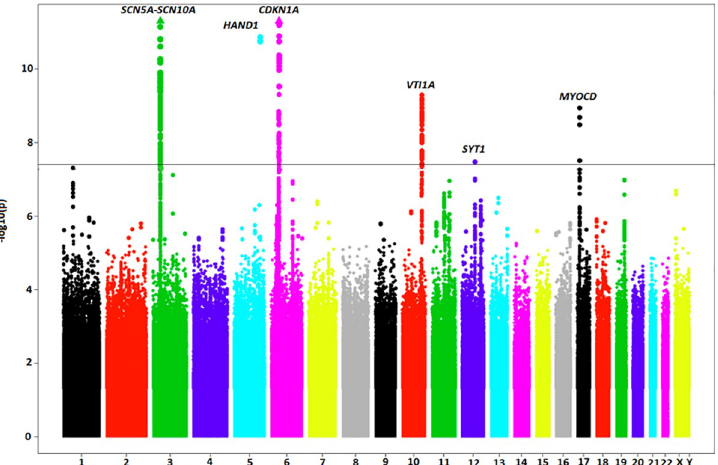
Fig 1. Manhattan plot of SNP-QRS associations. Manhattan plot showing the association of SNPs with QRS duration in the GWAS meta-analysis containing 15,124 individuals of Hispanic/Latino ethnicity. The horizontal line represents the genome-wide significance threshold of ( P = 5E-08). SNPs mapping to 6 loci exceeded the GWAS threshold for significance.